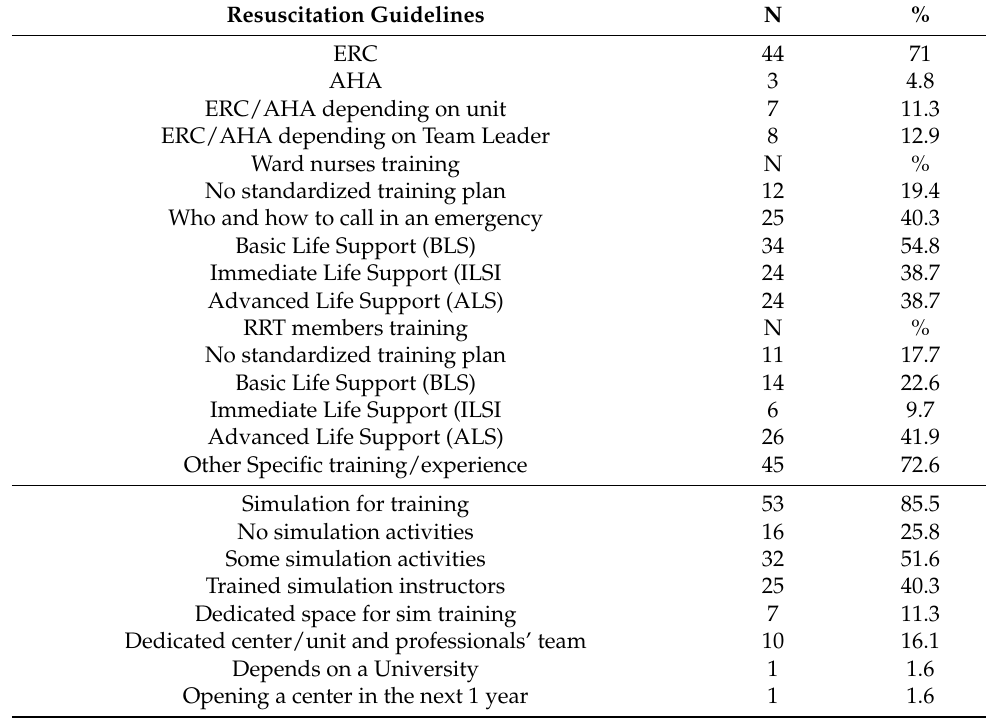
Table 4. Administrative limb: educational